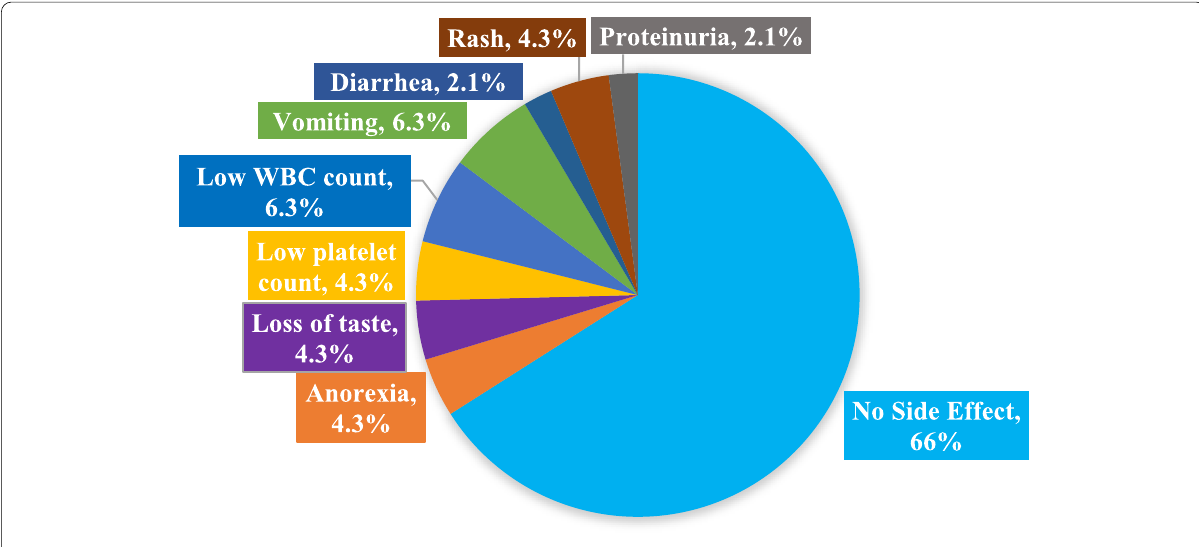
Fig. 12 Adverse effect of penicillamine (survived, n